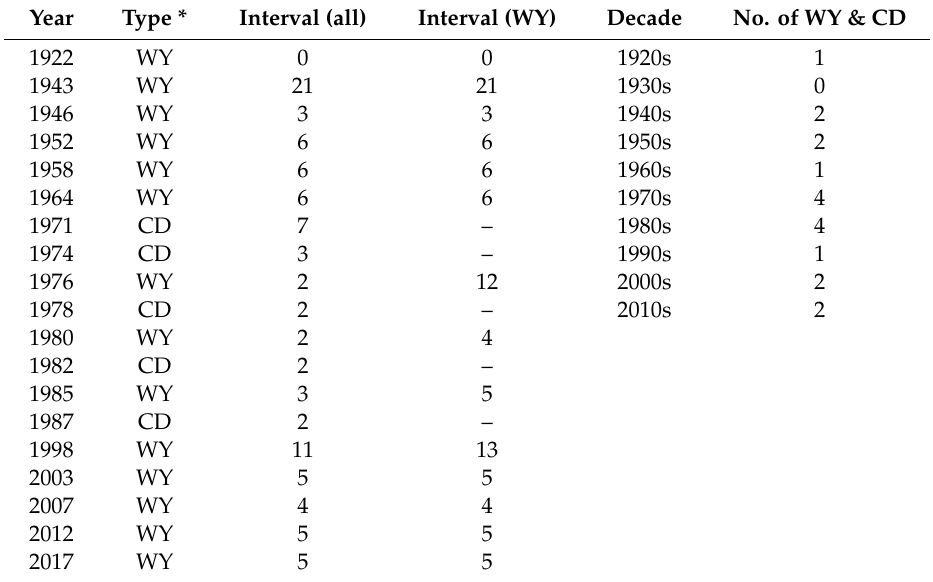
Table 1. Salvation rituals organized by Kwong Wai Siew Peck San Theng 新 加 坡 廣 惠 肇 碧 山 亭 (PST).